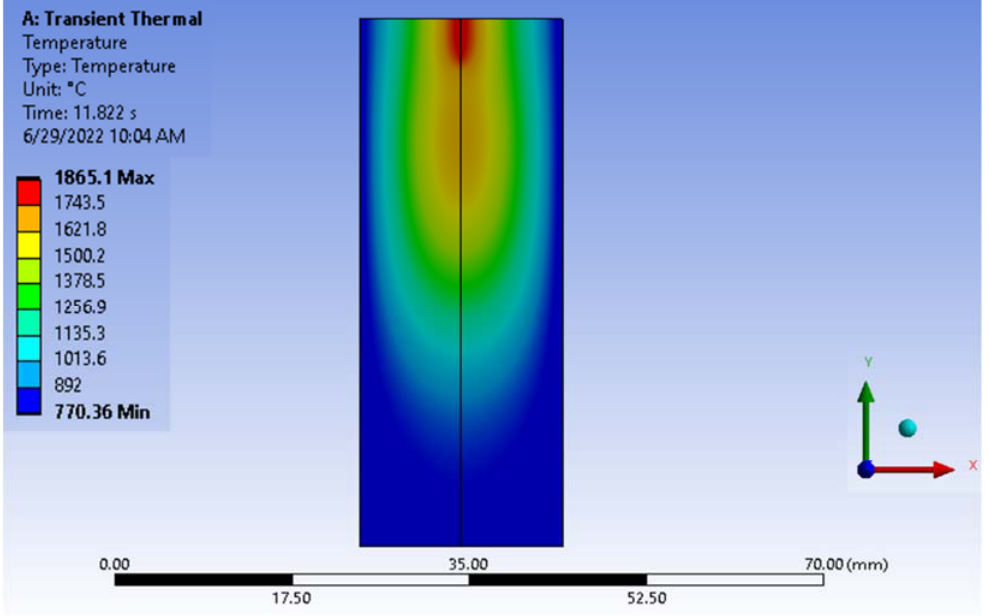
Figure 9. Top view of the temperature filed across the workpieces at the end of the simulation.